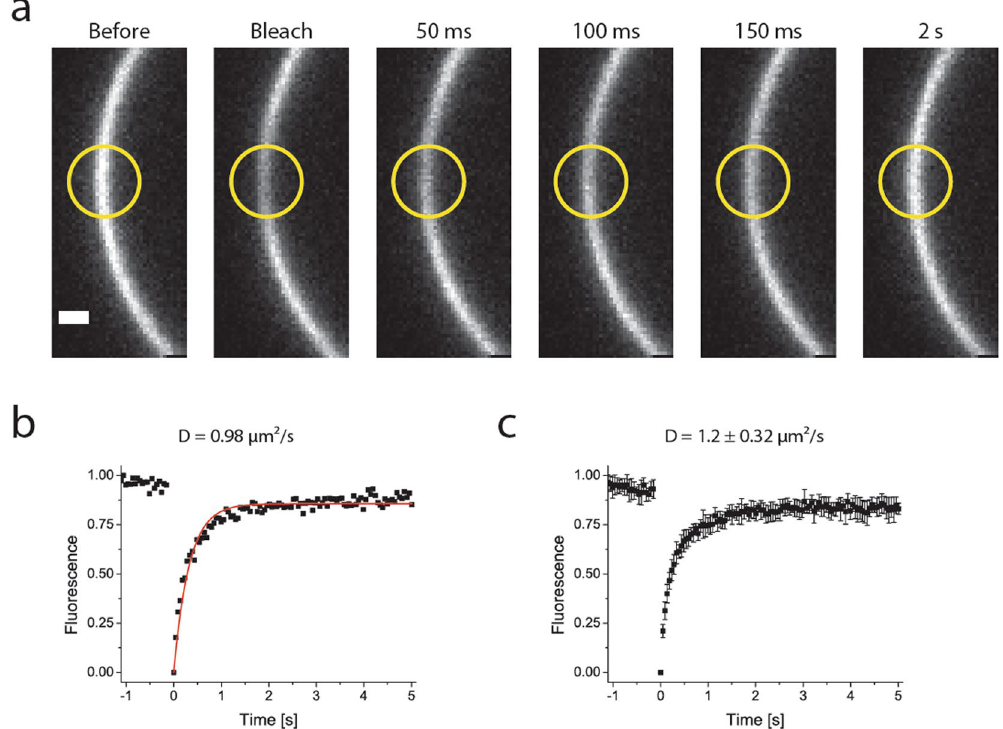
Figure 7. Lipid diffusion in the L d domain of GUVs, probed by FRAP. Panel a shows part of the microscopy images. The yellow circle indicates the bleached area. Panel b shows normalized fluorescence within the bleached area over time (black squares) and the fit of the data (red line). Panel c shows the average and standard deviation of normalized data from several experiments (n = 8). Scale bar is 1 µ